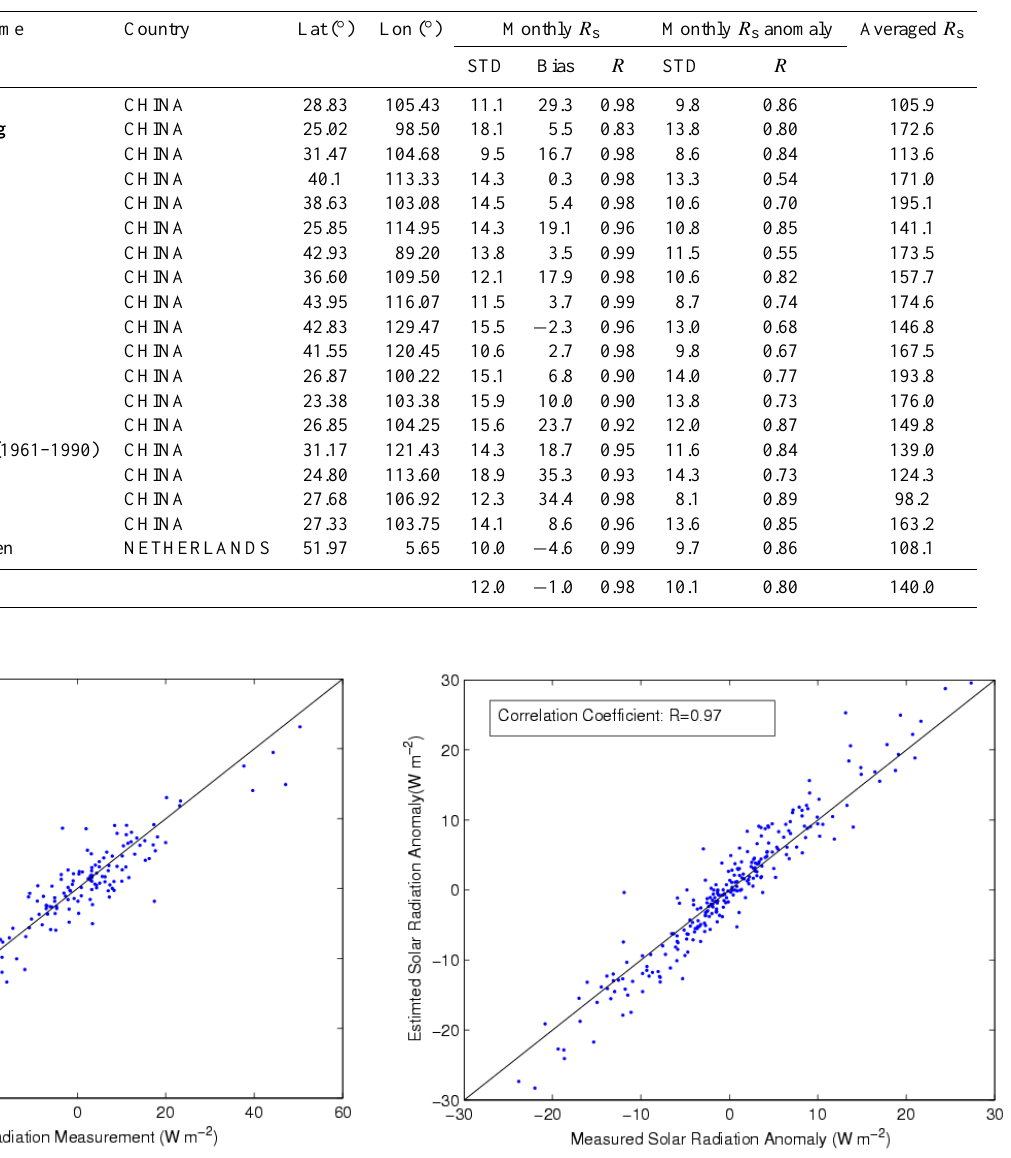
Fig. 4. Comparison between monthly regional R s anomalies of measurements and our prediction from SunDu. The regional average is over 86 stations in Europe (Table 1). Each point represents one month.